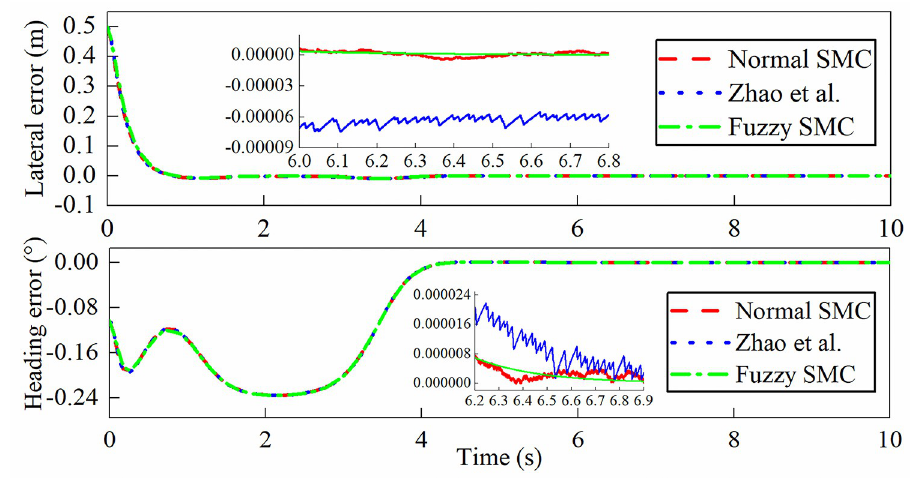
Fig 14. Lateral error, heading error.